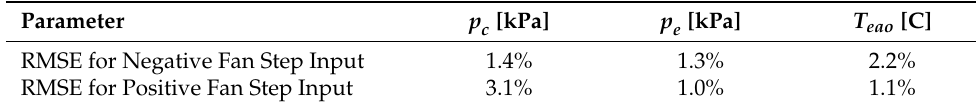
Table 4. RMSE between VEM and NL models for fan step input simulations.